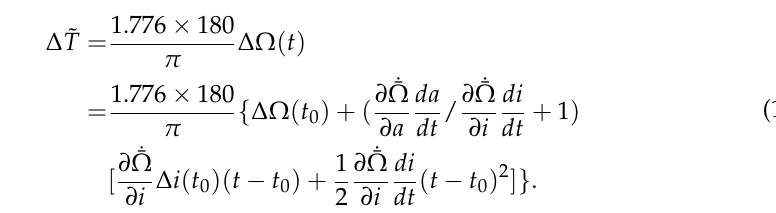
= 10 km, ∆ i = 3 × 10 − 4 deg, 0 0